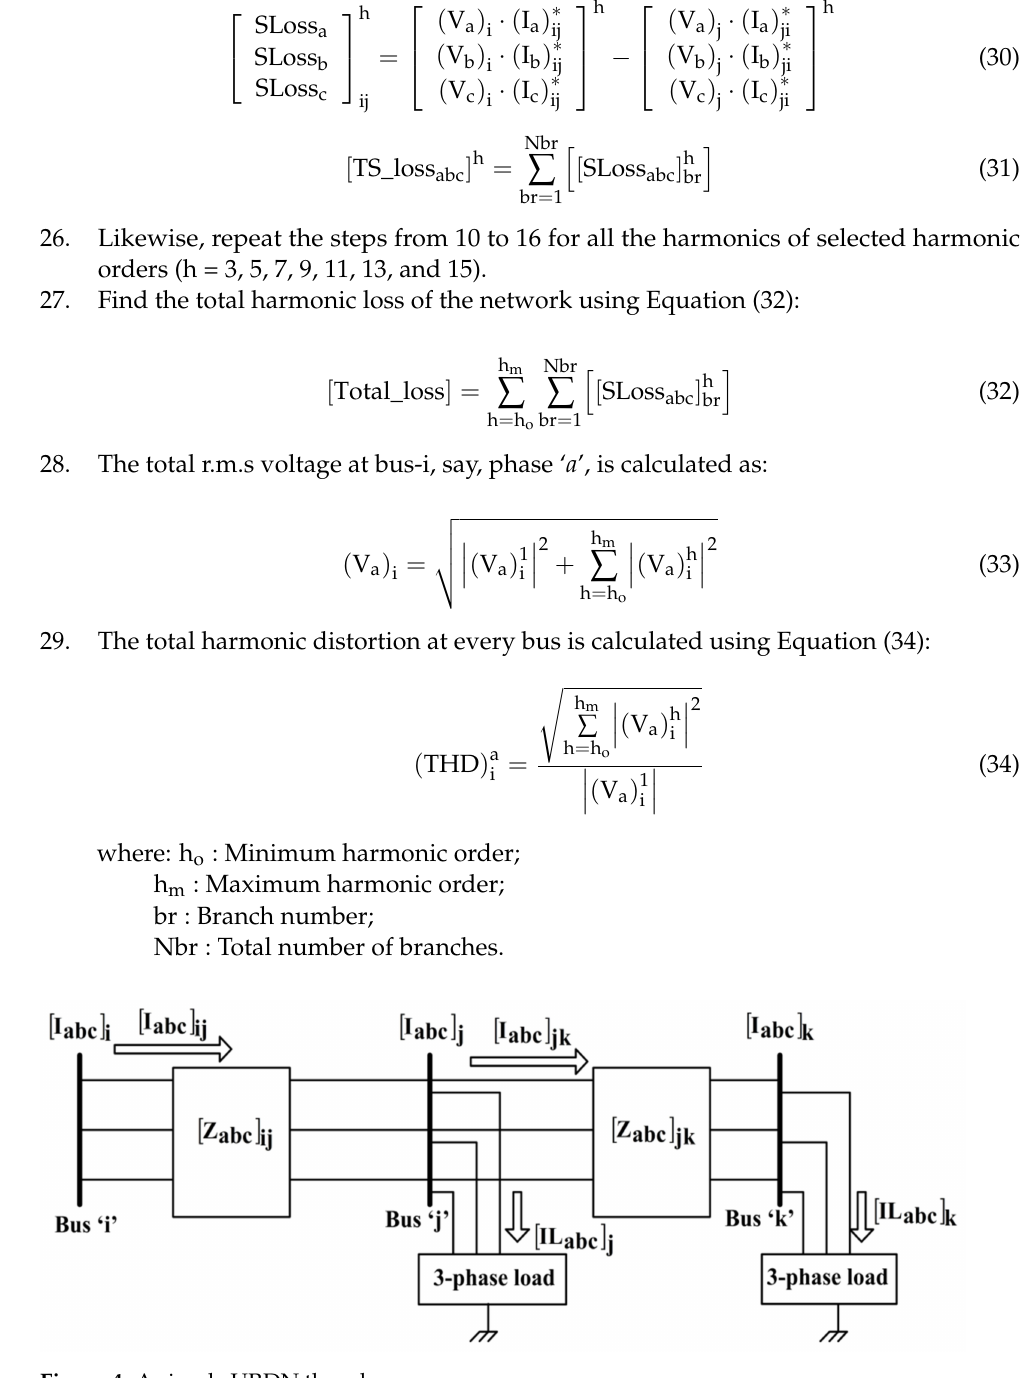
Figure 4. A simple URDN three